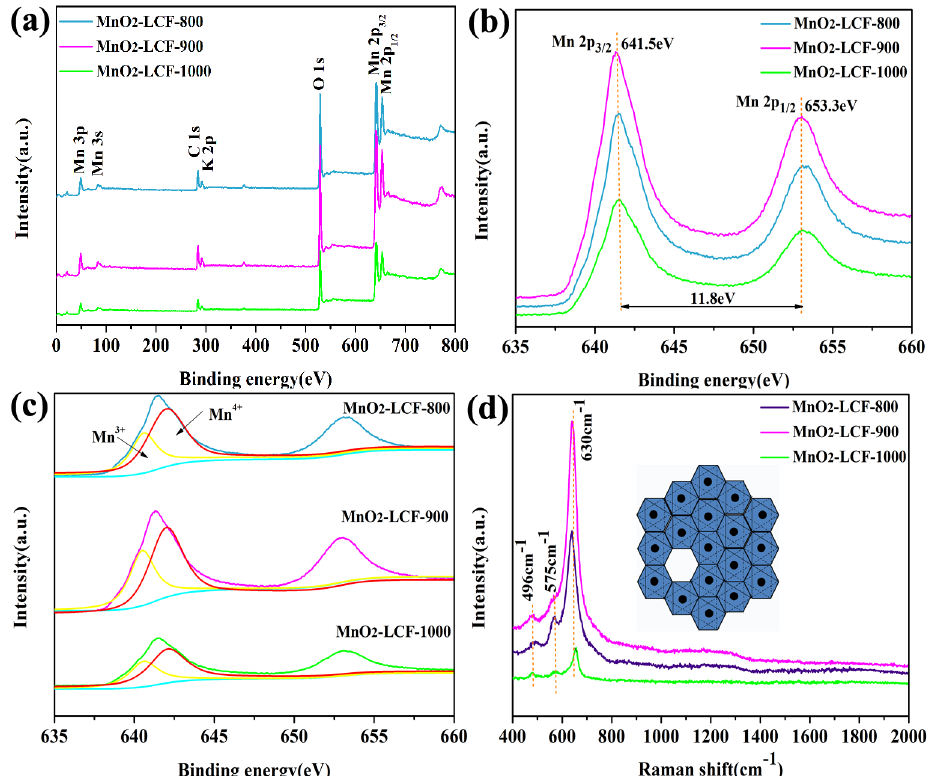
Figure 5. XPS spectra of the MnO 2 -LCF samples ( a ); Mn2p spectra ( b ); fitting results of Mn2p 3/2 spectra ( c ); Raman spectra of the MnO 2 -LCF mats ( d ). The built-in illustration is the top view of Birnessite-type MnO 2 along the direction of [001], and the vacancy in the picture is the vacancies in MnO 2 .